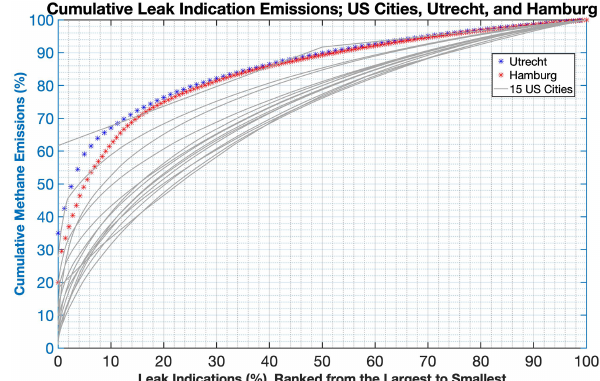
Figure 3. Total CH 4 emissions in Utrecht and Hamburg; the ar- row shows how the total emissions are distributed on different road classes.